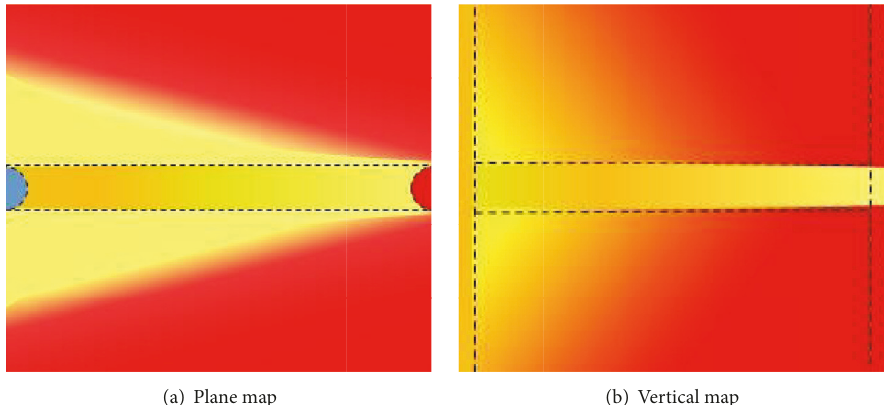
Figure 2: CO 2 (yellow) and oil (red) distribution and profile schematic diagram in the late stage.